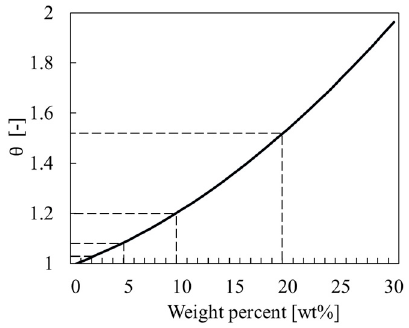
Figure 3. Effects of specific viscosities on different PCM weight percentages.